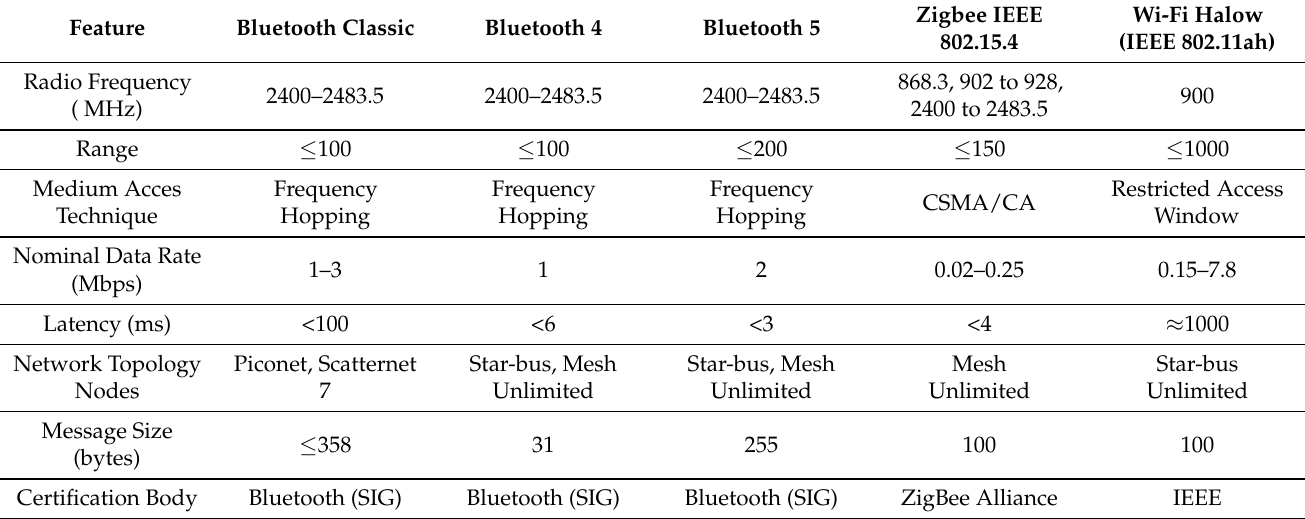
Table 2. Technical Comparison of Bluetooth versions and other Wireless technologies